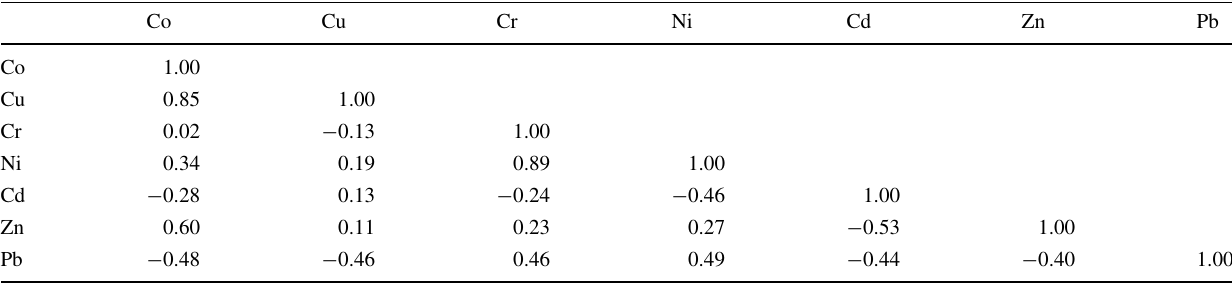
Table 7 Correlation matrix between heavy metals analyzed in sediment of the river Ghaghara